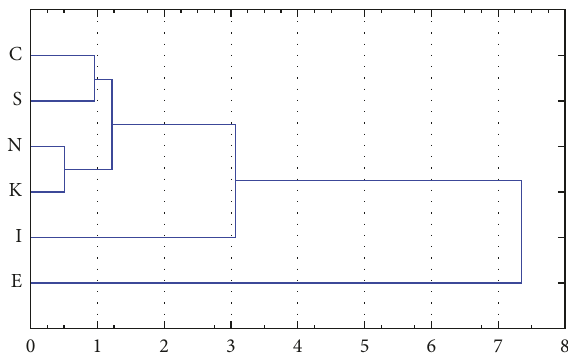
Figure 1: Single-linkage hierarchical cluster dendrogram for tested salmon samples: C, Norway-Central; S, Norway-South; N, Norway- North; K, Scotland; I, Iceland; E,